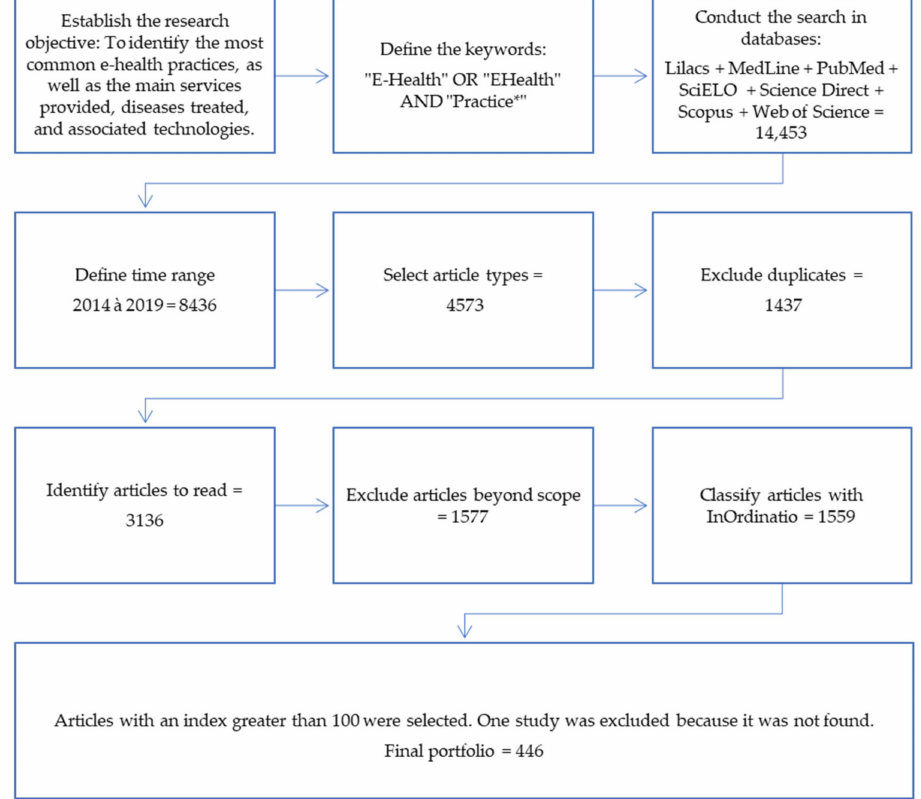
Figure 1. Research